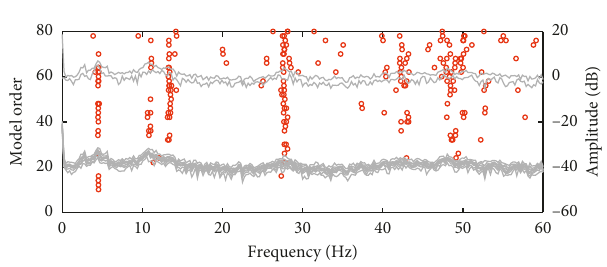
Figure 11: Stabilization diagram after eliminating spurious poles.